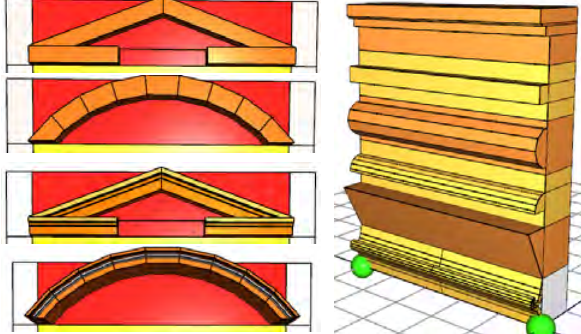
Figure 6: Different mouldings on assets created by the frame operation. Pediment and cornice are generated in a generic way (upper left), the moulding is then applied using a specific profile (lower left). The differnt mouldings (right) are defined indepen- dently from the assets that they are applied